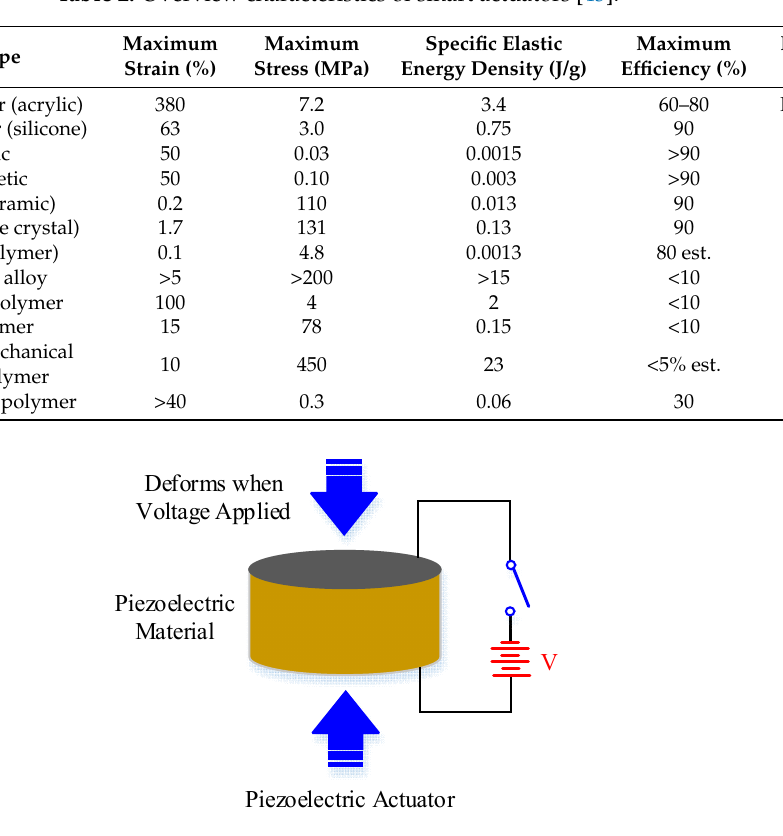
OffCompliant Electrodes (on top and bottom